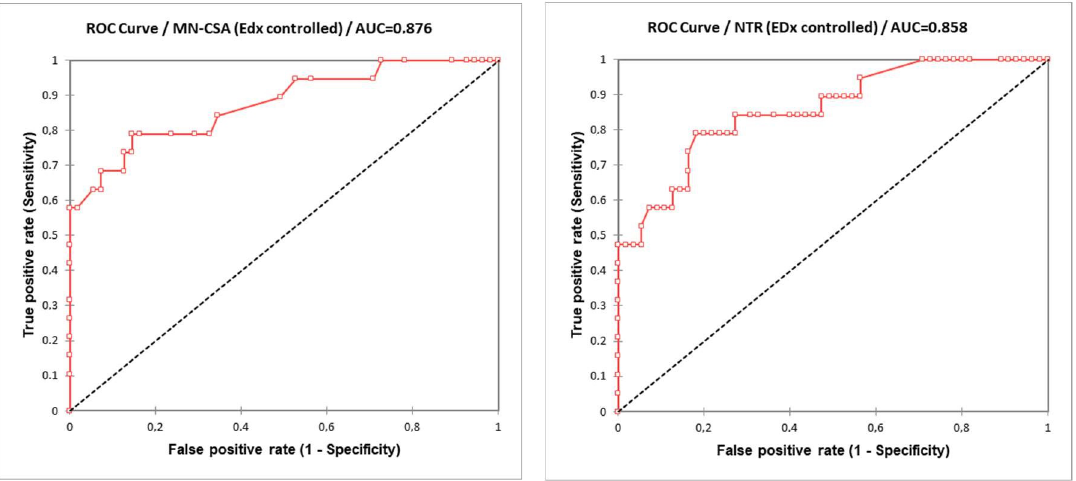
Figure 4. ROC curves obtained comparing each US parameter (MN-CSA and NTR) in severe EDS- defined (PS > 3) diagnosis of CTS (as gold standard).